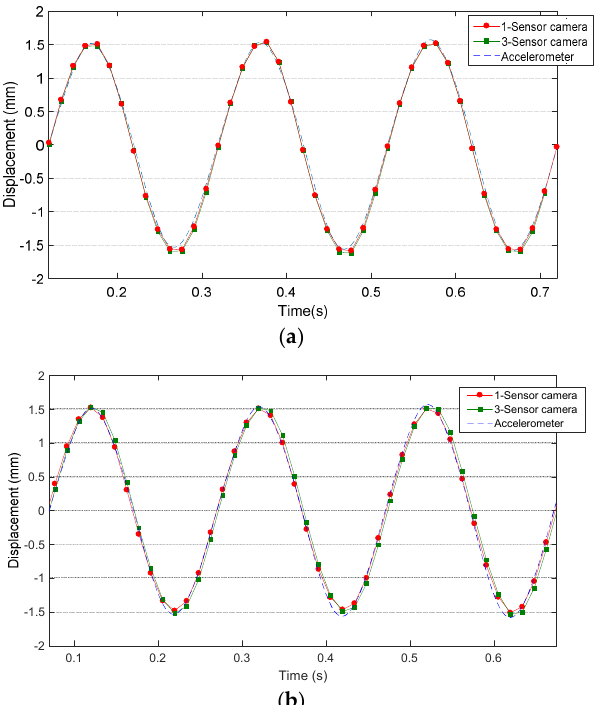
Figure 10. Mean ∆ z displacement measured by 3-sensor camera (green) and 1-sensor camera (red) during vibration test employing ( a ) an LCD projector and ( b ) a laser projector together with accelerometer data (blue).